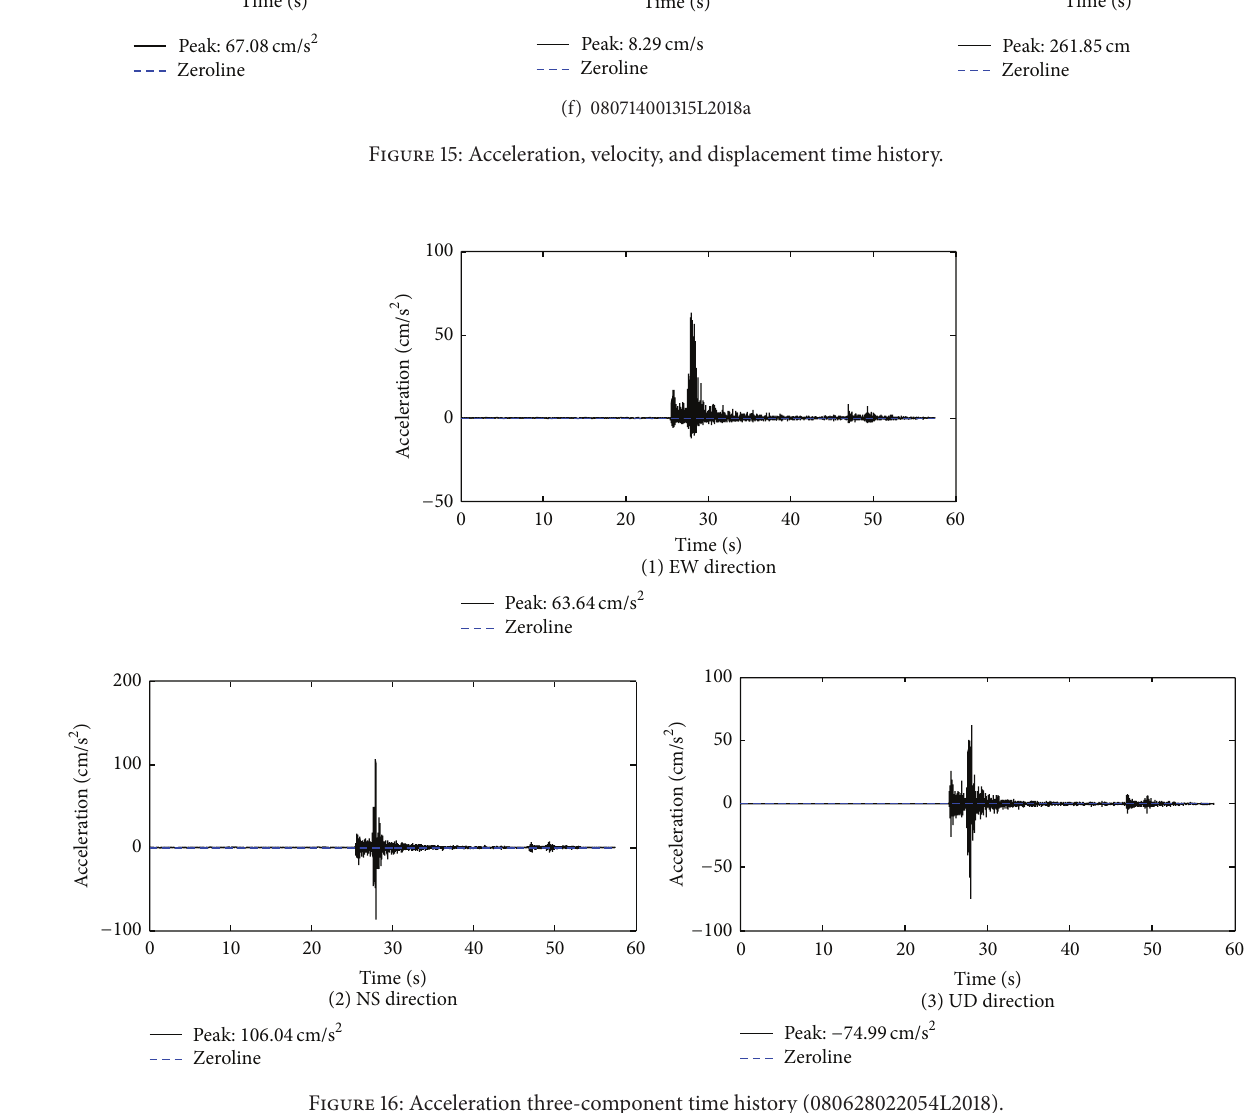
Figure 16: Acceleration three-component time history